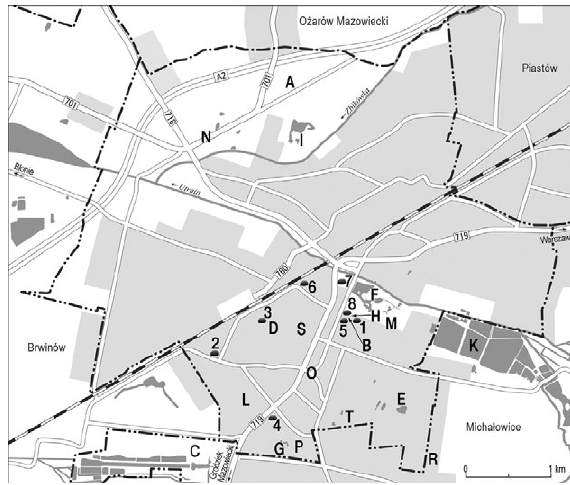
Fig. 2. Objects of abiotic heritage in